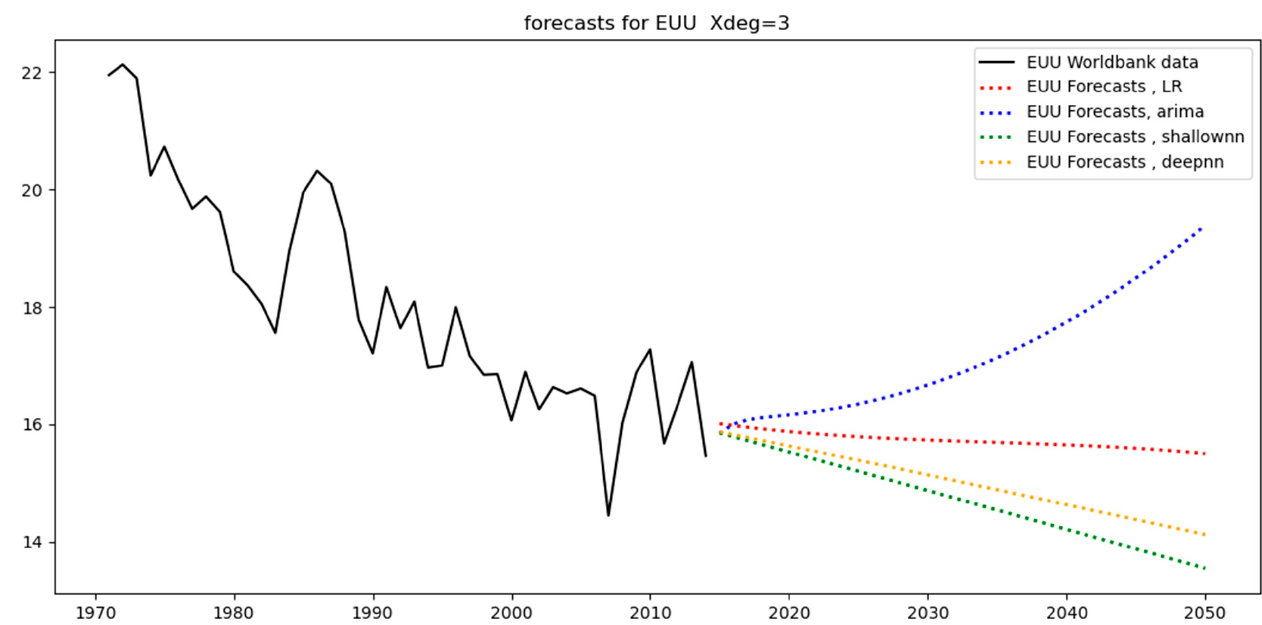
Figure 17. Forecasts for the EUU, using linear regression (LR), ARIMA, shallow neural networks (shallownn), and deep neural network (deepnn) models (third-degree polynomial).